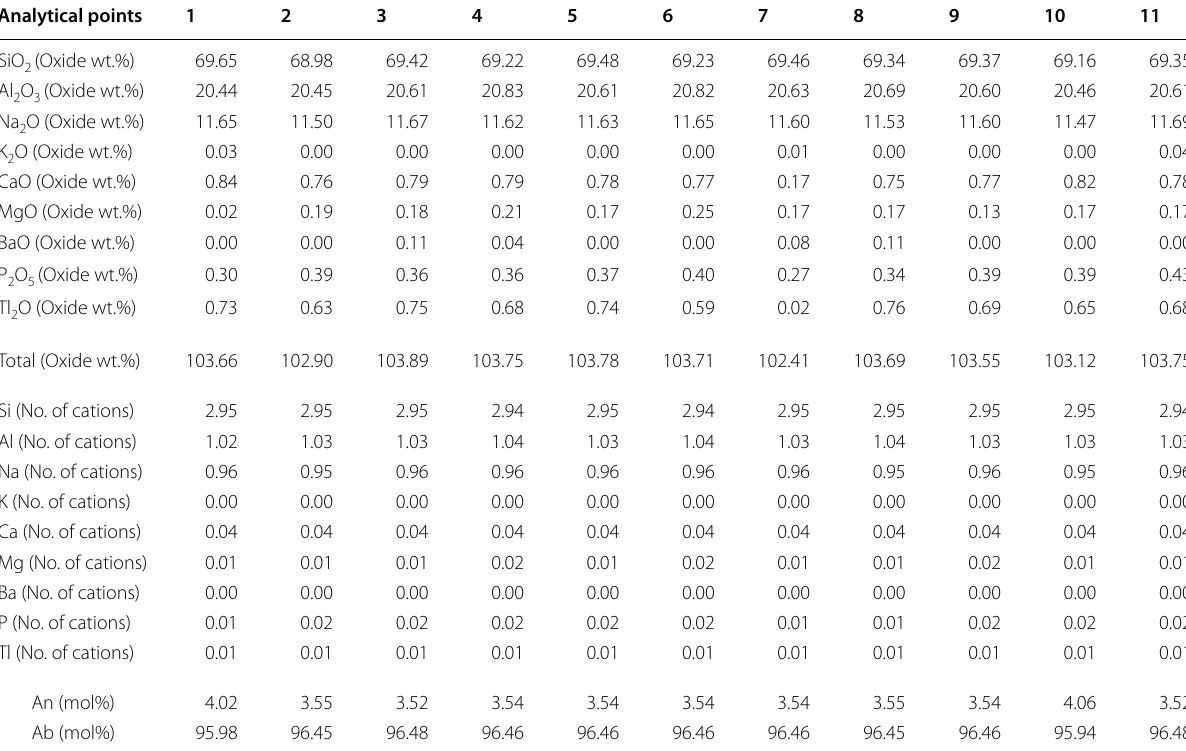
Table 4 Example of chemical compositions of a hot‑pressed sample (Exp. #13) Analytical